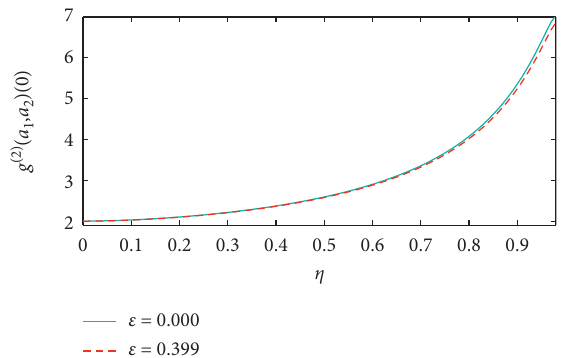
Figure 19: Plots of the normalized second-order correlation function (equation (41)) versus η for A � 100, κ � 0 . 8, n th � 0 . 15 and for different values of ε .